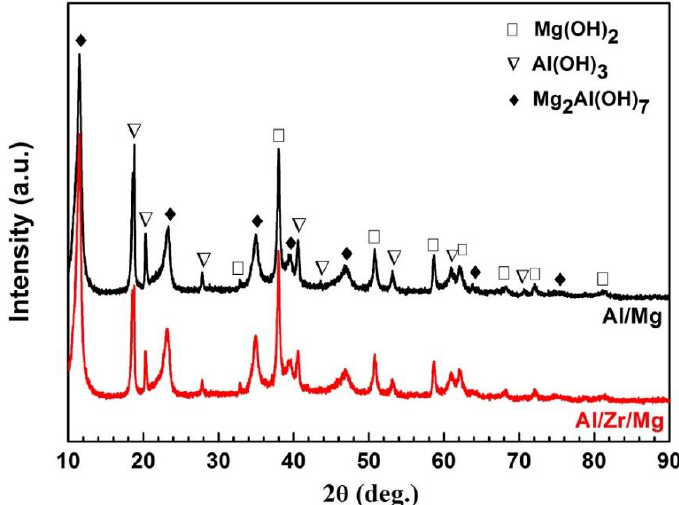
Figure 12. XRD patterns for the corrosion products of the Al/Mg and Al/Zr/Mg joints.